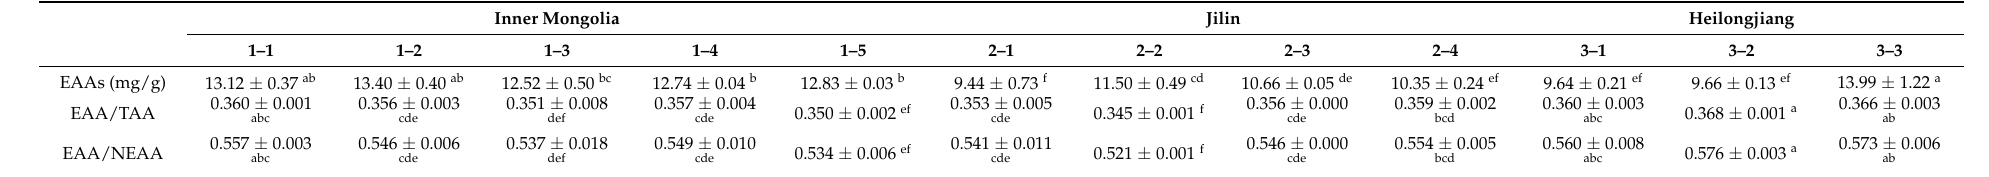
Table 4. EAAs, NEAAs, and ideal protein patterns of fresh corn in three